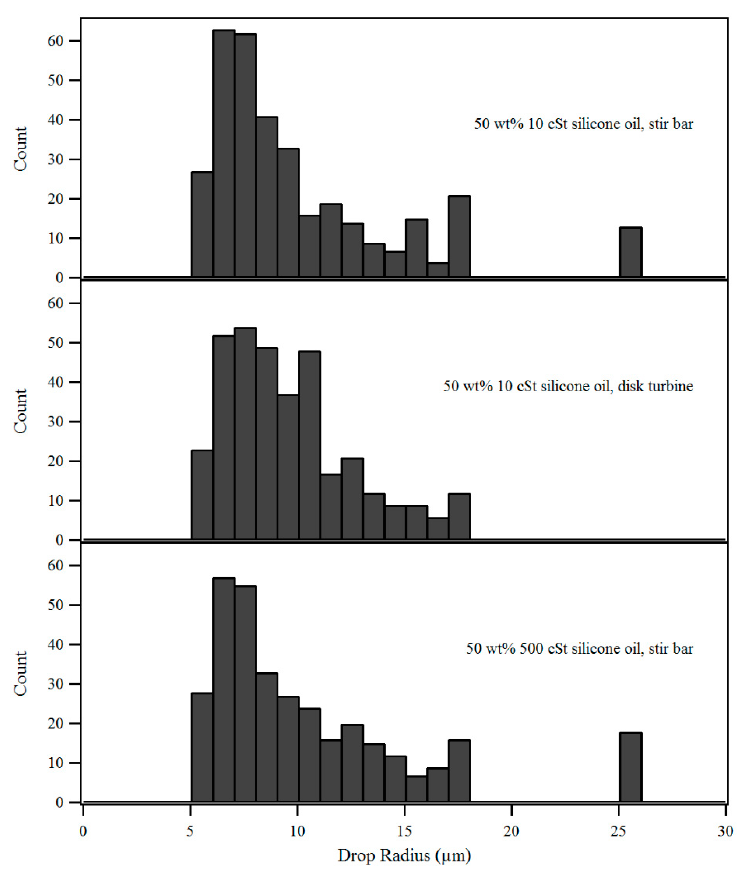
Figure 6. Droplet size distributions for three different emulsion preparations, n = 350 for each distribution. Gels 2016 , 2 , 14 Table 1. Description statistics for the droplet size distributions of three different emulsion preparations, n = 350 for each.